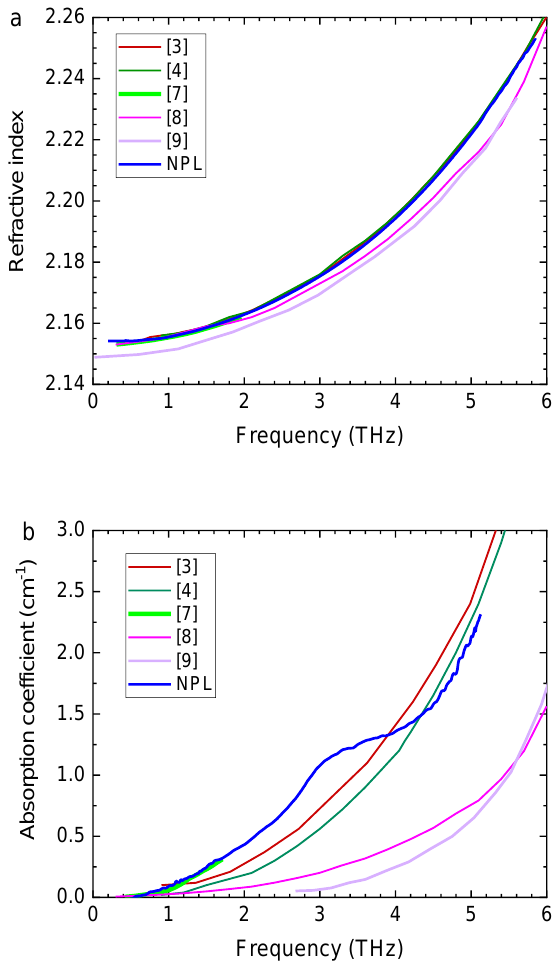
Figure 6. THz optical parameters for the extraordinary ray transmission in quartz crystal. Data re- ported in the literature are shown together with the results of this work. ( a ) refractive index; ( b ) absorption